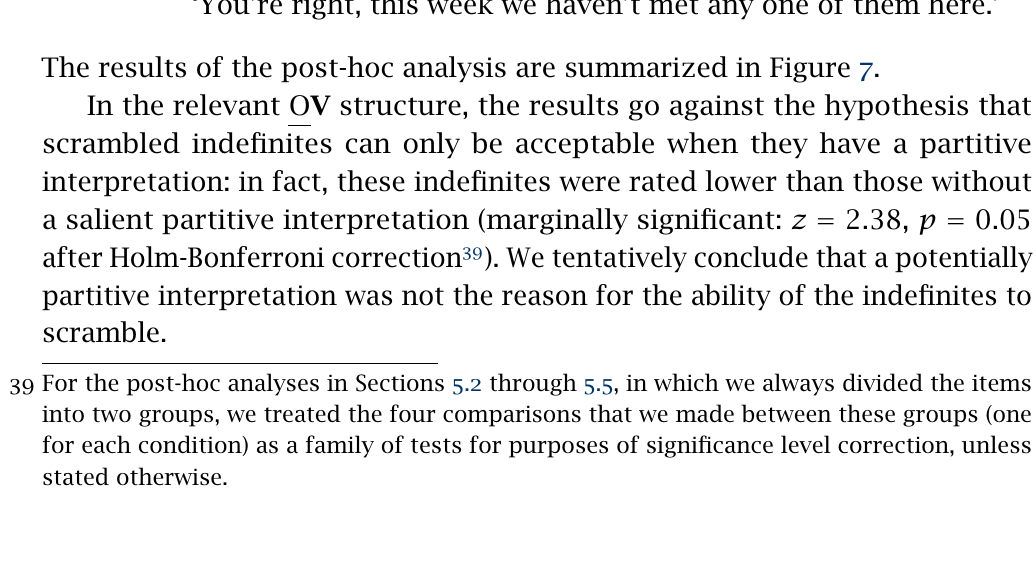
Figure 7 Results of the post-hoc analysis for partitive interpretation; me- dians in boldface, IQR in parentheses b. Máš pravdu, tento týden už jsme tady aux . 1pl have. 2sg truth. acc this week. acc already here žádného nepotkali. neg .met no. nci.det . acc ‘You’re right, this week we haven’t met one here.’ c. Máš pravdu, tento týden už jsme tady aux . 1pl have. 2sg truth. acc this week. acc already here žádného z nich nepotkali. neg .met no. nci.det . acc of them. gen ‘You’re right, this week we haven’t met any one of them